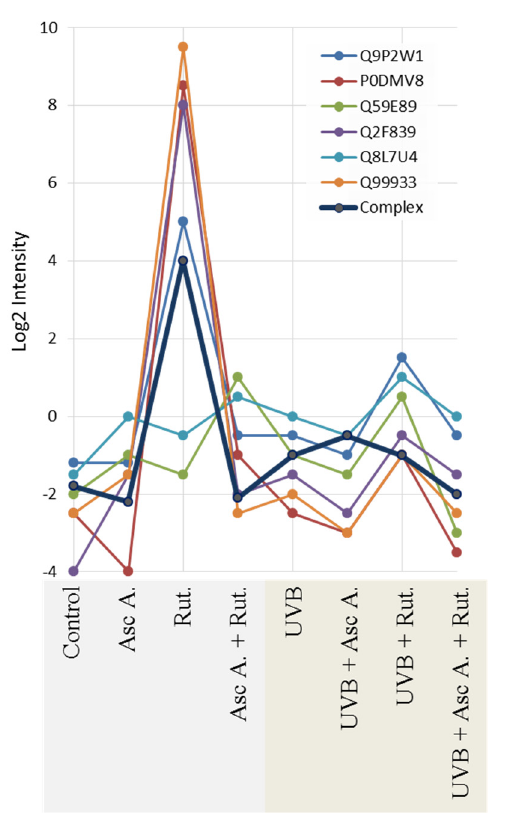
Figure 3. The intensity of the proteins creating complex with active heat shock protein 90 (HSP90) in 3D cultured fibroblasts treated with rutin [25 μ M] and/or ascorbic acid [100 μ M], and exposed to UVB irradiation (200 mJ/cm 2 ). Abbreviations: Asc A, ascorbic acid; Rut, rutin. Proteins: P0DMV8—heat shock protein 70 (HSP70); Q2F839—heat shock protein 90 (HSP90); Q59E89—heat shock protein 40 (HSP40); Q8L7U4—co-chaperone protein p23; Q99933—BAG family molecular chaperone regulator 1; Q9P2W1—homologous-pairing protein 2 (HOP2). Analysis made using ComplexBrowser.